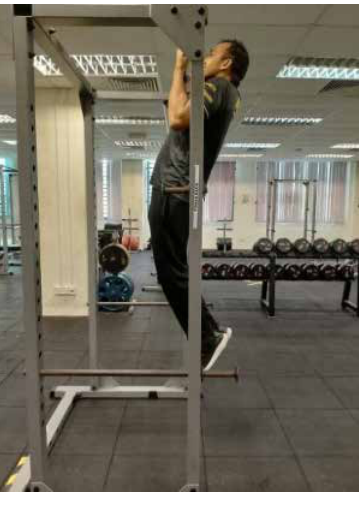
chin-upStart Figure 1. Starting and middle position of straight knee